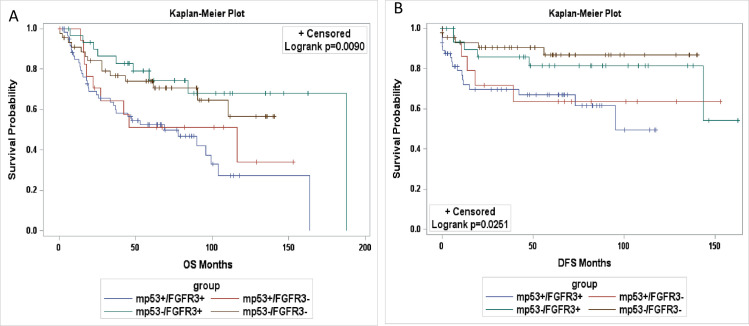
Kaplan–Meier (KM) estimates of overall survival (OS) and disease-free survival (DFS) using FGFR3 and mp53 levels in patients with OPSCC.KM plots were generated using median weighted index (WI) of mp53 (3.5) and FGFR3 (35) as the cut off values (>median as positive and ≤ median as negative). High FGFR3 and mp53 levels correlated with worse OS (A) and DFS (B).